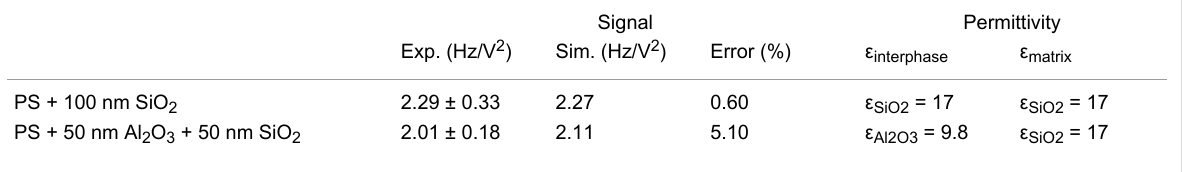
Table 2: Experimental data and simulations for PS + 50 nm Al 2 O 3 + 50 nm SiO 2 and PS + 100 nm SiO 2 . The Al 2 O 3 subsurface layer had a dielectric permittivity value of 9.8 (error = 5%) for a calibrated SiO 2 upper layer with an apparent permittivity value of 17 (step A).